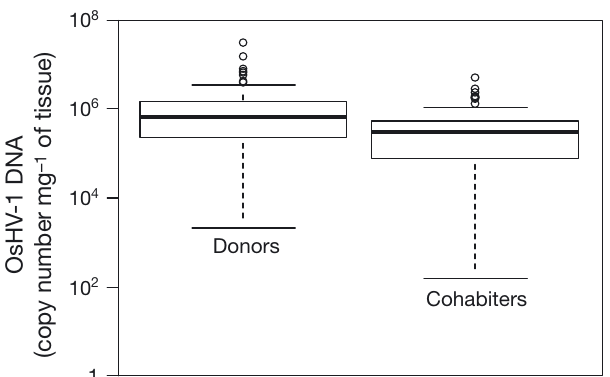
Fig. 3. Level of OsHV-1 DNA at the time of death for Pa- cific oysters depending on the challenge method used for OsHV-1 exposure; either by injection (donors) or cohabita- tion (cohabiters). The black bar is the median and the edges of the box indicate the quartiles 1 to 3. The horizontal bars at the end of the lines are the minimum and maximum values excluding the outliers, indicated as dots. The difference in viral load was significant (p <